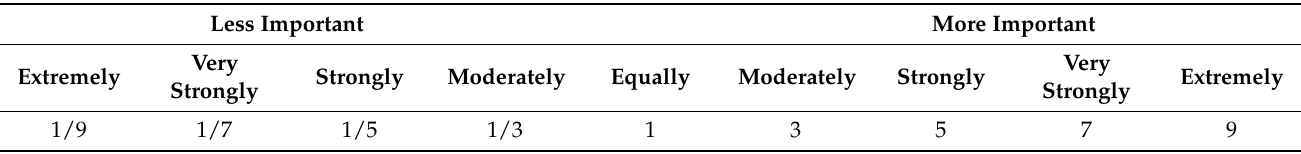
Table 2. Saaty’s scale for weight assignment adapted from